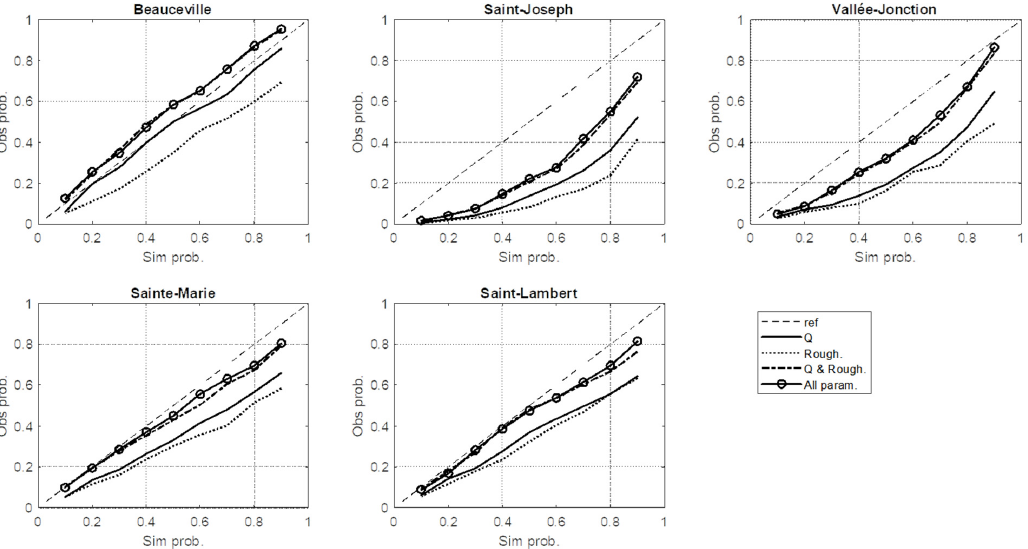
Figure 13. Mean continuous rank probability score (MCRPS) gain in % over the mean absolute error (MAE) for various locations and ensemble subsets.